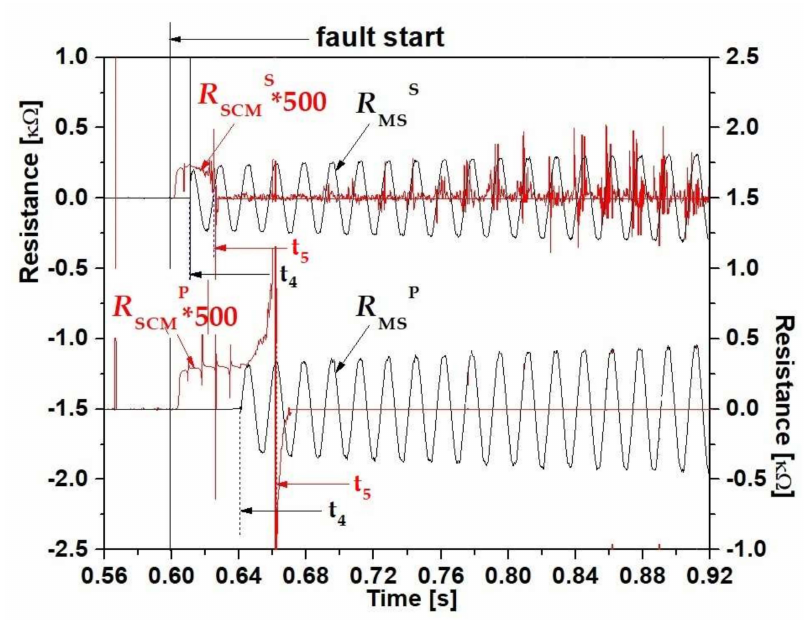
Figure 9. Resistance variations of the SCM and MS ( R SCM , R MS ) for the breaking time analysis of the SFCLB using flux coupling after the fault occurrence due to the winding